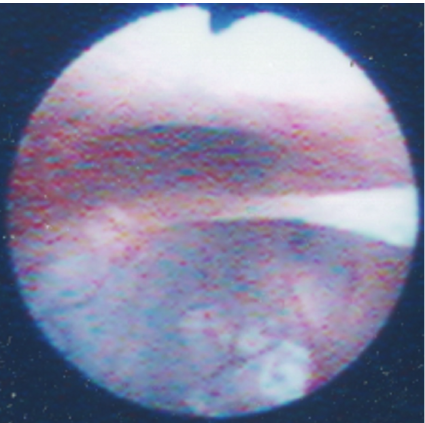
Figure 1: Cystoscopic view of the anterior urethra, showing the true lumen and the urethral diverticulum. A band of tissue separates the two, and this was subsequently